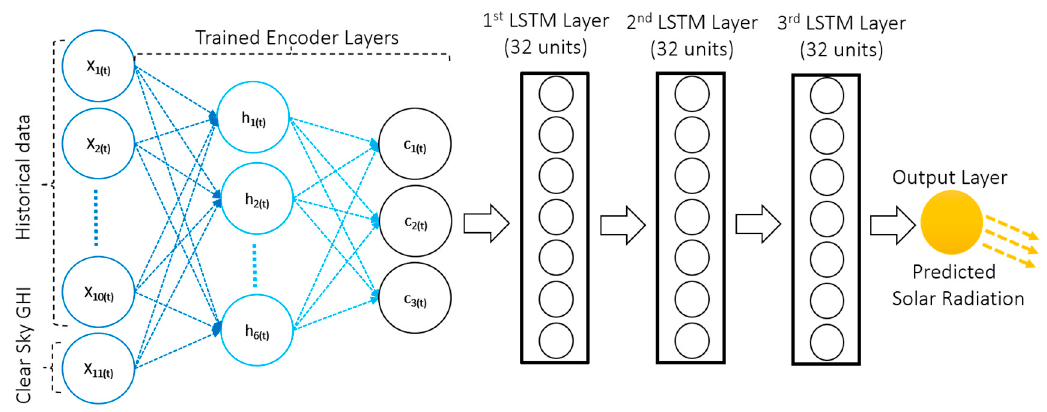
Figure 9. Fully connected AE-LSTM predictive model. Energies 2020 , 13 , 4373